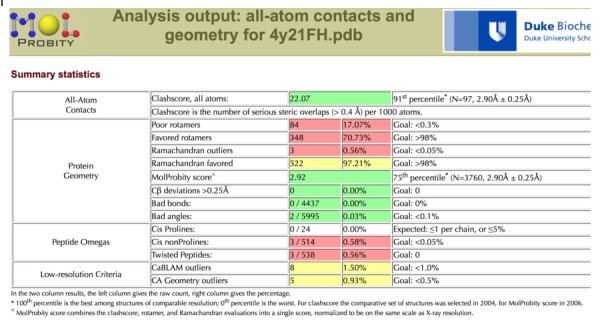
DOI:
http://dx.doi.org/10.7554/eLife.22567.029